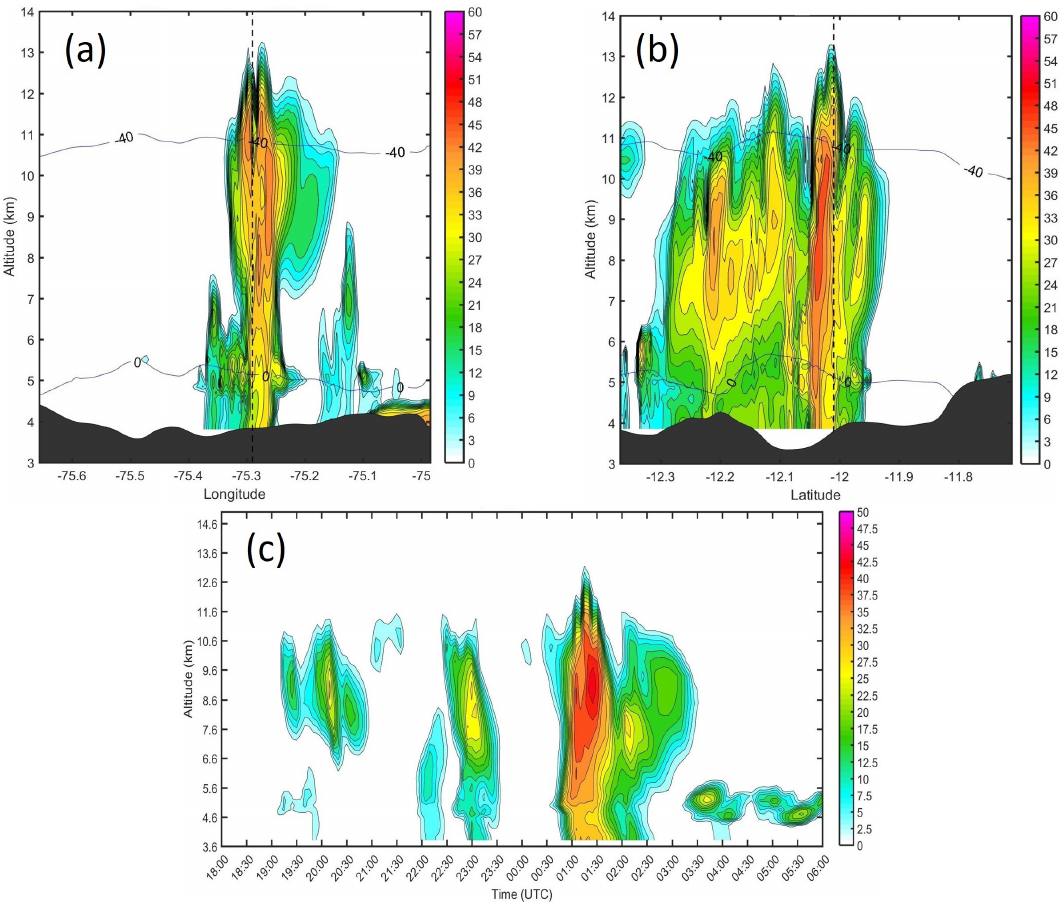
Figure 15. Mean reflectivity (dBZ) along ( a ) longitude and ( b ) latitude obtained from the ARPS model (resolution: 0.5 km) at 0115 UTC (2015 LT) of 30 December, 2015. Black dotted lines indicate the location of the Huancayo observatory (Figure 1a); ( c ) Time series of mean reflectivity (dBZ) above the Huancayo observatory (Figure 1a) obtained from the ARPS model (resolution: 0.5 km) using the algorithm of Kessler [68] which combines the mixing ratios of all hydrometeors. The mean values were obtained inside a square of 1 km around the Huancayo